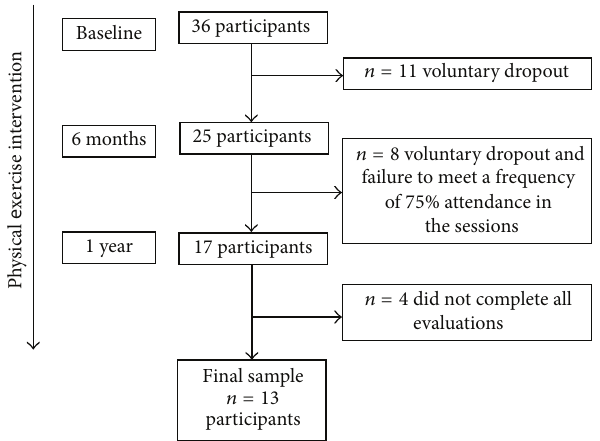
Figure1:Recruitmentofparticipantsforthestudy.Evaluationswere done at baseline, 6 months, and 1 year of SARC